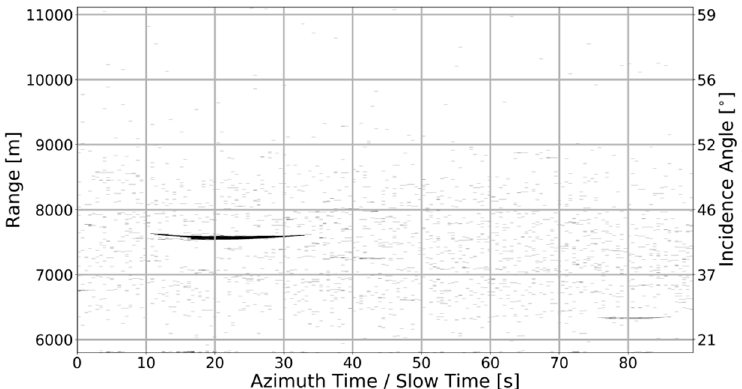
Figure 11. Binary detection map after applying the proposed pre-detection algorithm. The pre-detected ship signal (left) as well as spiky clutter peaks can clearly be seen .